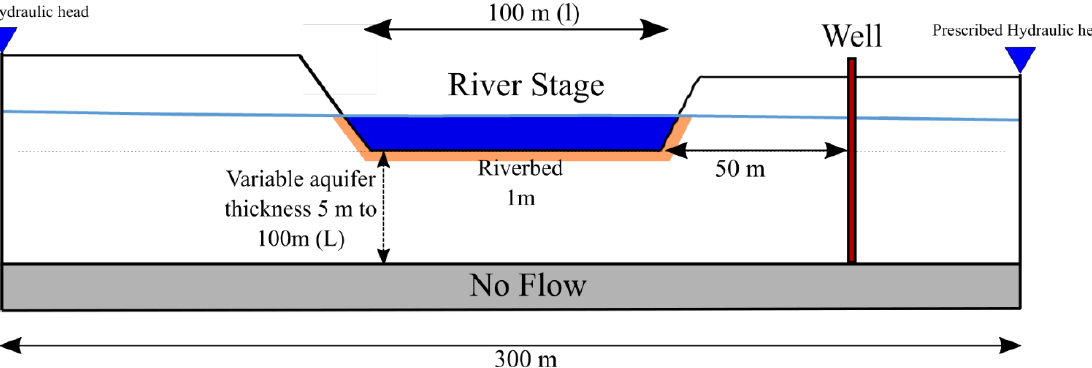
Figure 1. Schematic diagram of simulated domain with the different boundaries, a no-flow boundary at the bottom of the model, two prescribed head boundaries on the right and the left sides.